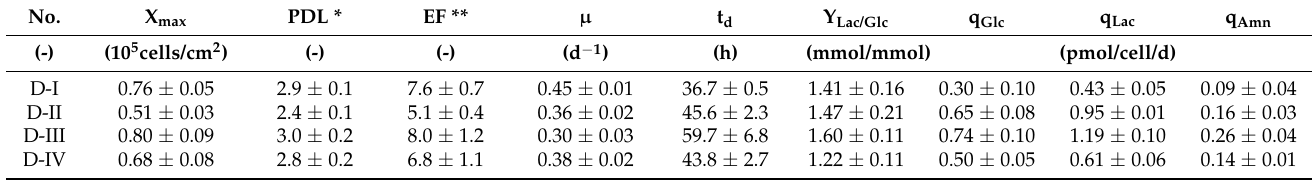
Table 2. Overview of the main growth-dependent parameters in the 2D cultivations (n = 2 per